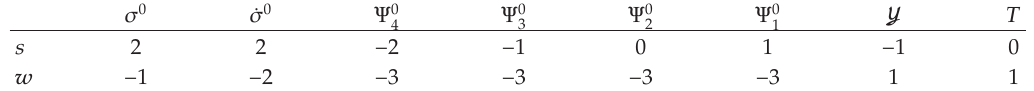
Table 1: Spin and conformal